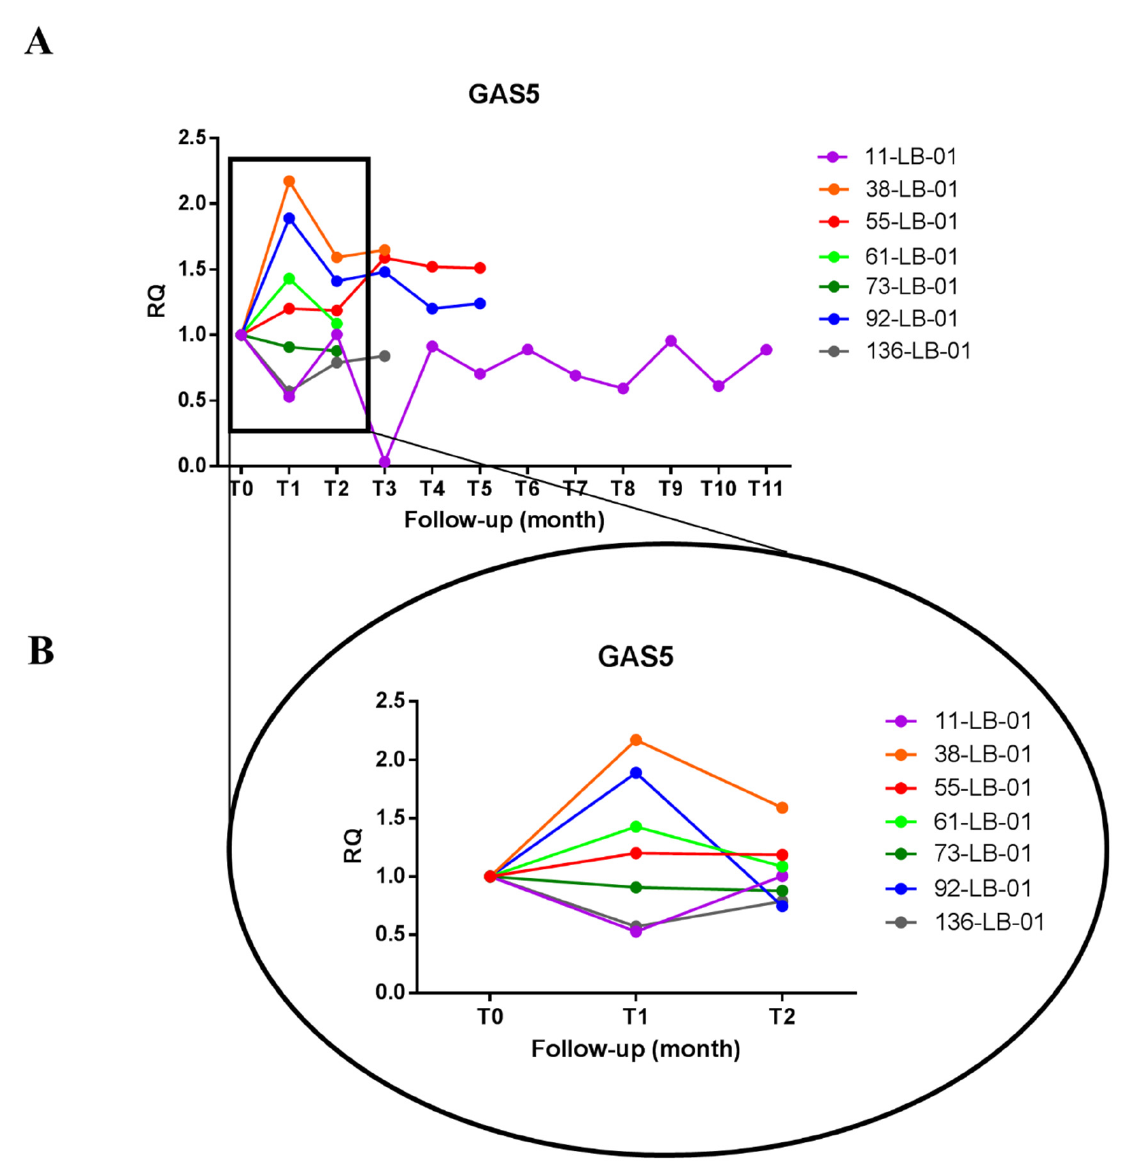
Figure 1. GAS5 levels in the plasma of HCC patients treated with sorafenib. ( A ) The graph shows the amount of GAS5 detected in the plasma of each HCC patient during sorafenib treatment. Each line represents one patient, and the dots indicate the levels of GAS5 at each blood withdrawal time point (one per month, Tn) normalized on the GAS5 level before the start of treatment (T0). ( B ) Focus on GAS5 early levels after sorafenib administration. T n indicates the sequential blood withdrawal time point carried out once per month. One-way ANOVA, followed by Tukey’s test, was used to compare GAS5 levels among three time points (T0, T1 and T2).